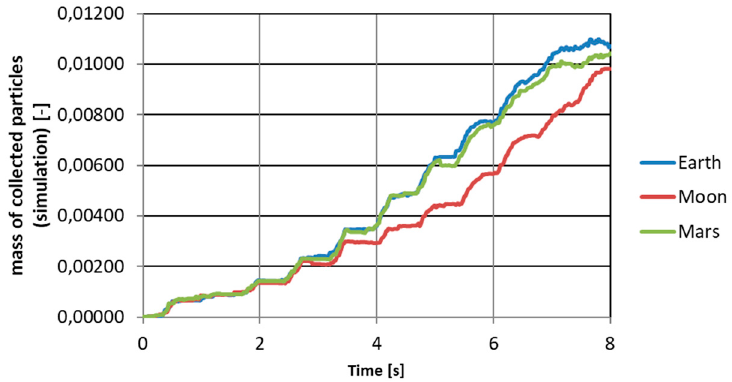
Figure 15. Mass of collected particles in time for different gravitational conditions.